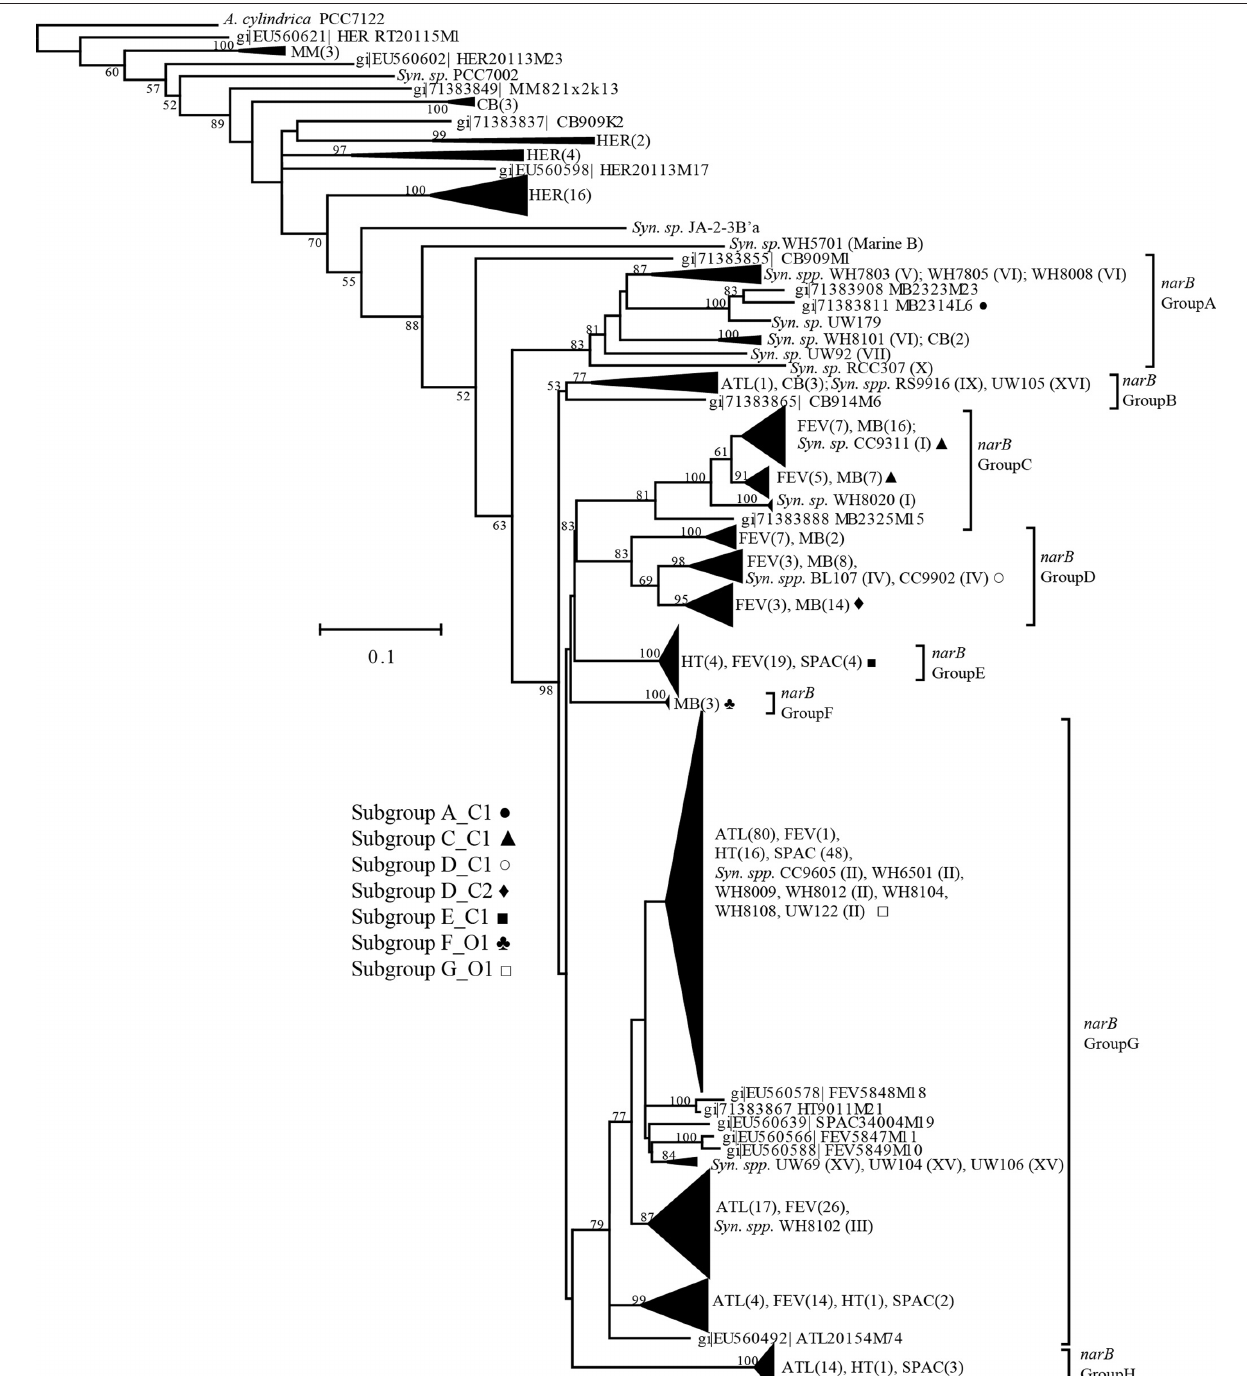
FiguRe 2 | A phylogenetic tree of aligned narB sequences from Synechococcus isolates and environmental samples. The tree was constructed using a neighbor-joining, Jukes-Cantor corrected method in MEGA3 (Kumar et al. , 2004). Bootstrap values were obtained from the generation of 1000 replicate trees initialized with a random seed. Bootstrap values < 50 are not shown. Next to collapsed branches are abbreviated sequence names (unique to the sampling site, e.g., ATL, N. Atlantic) and the number of these sequences in branch. narB cluster names are from Paerl et al. (2008) and are next to bracketed